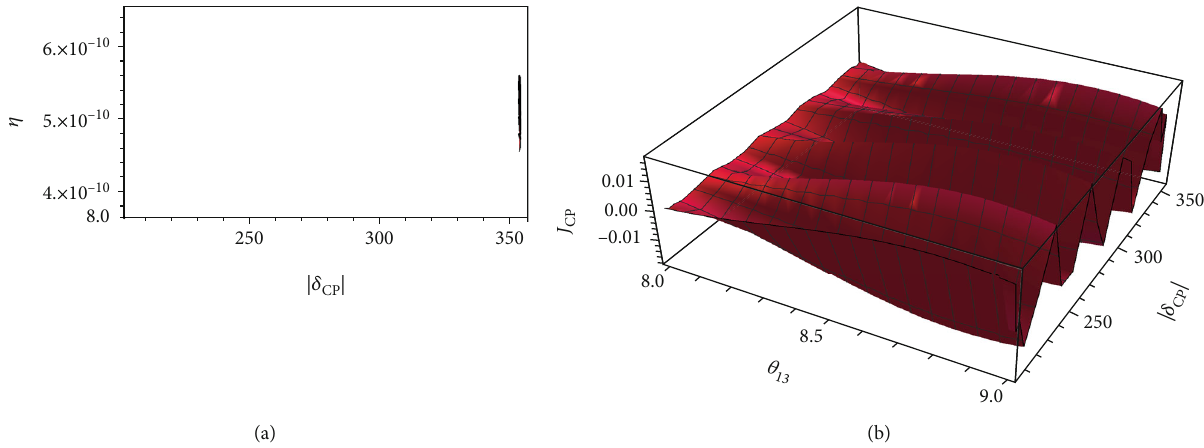
Figure 15: Predictions in the broken μ − τ symmetry model for inverted ordering. (a) Predicted the favoured values of δ recent ratio of the baryon to photon density bounds, 5 : 8 × 10 − 10 < η < 6 : 6 × 10 − 10 ) for the lightest ν mass m contribution of the type I seesaw mechanism to neutrino mass matrix. Similarly, (b) predicted the allowed three-dimensional space of the Þ plane for allowed regions of Jarkslog invariant, J ð δ , θ , J CP 13 CP contribution of the type I seesaw mechanism to neutrino mass